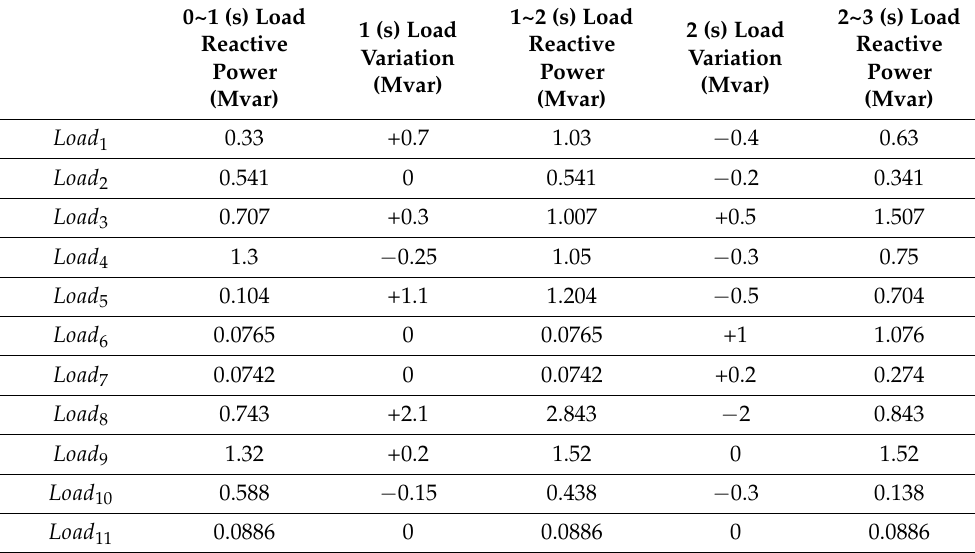
Table 4. Virtual STATCOM Simulation Model Parameters (Load